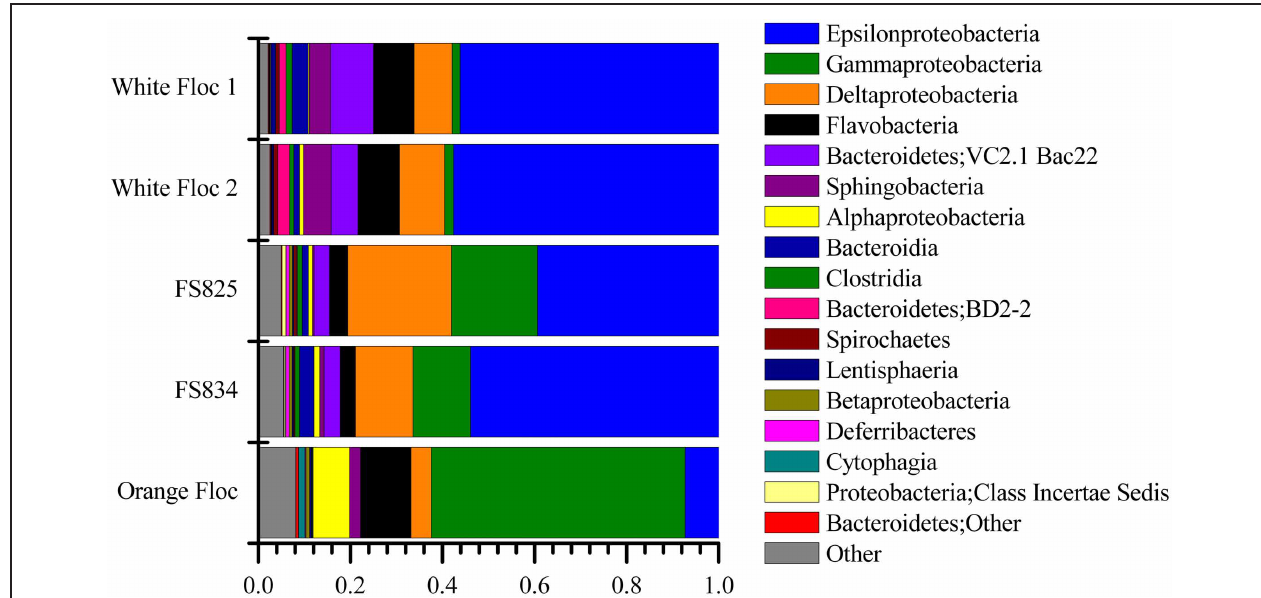
FIGURE 4 | Relative abundance of dominant bacterial classes in Illumina amplicon libraries from white floc and fluid samples from active snowblower vents as well as orange floc from the surrounding seafloor.